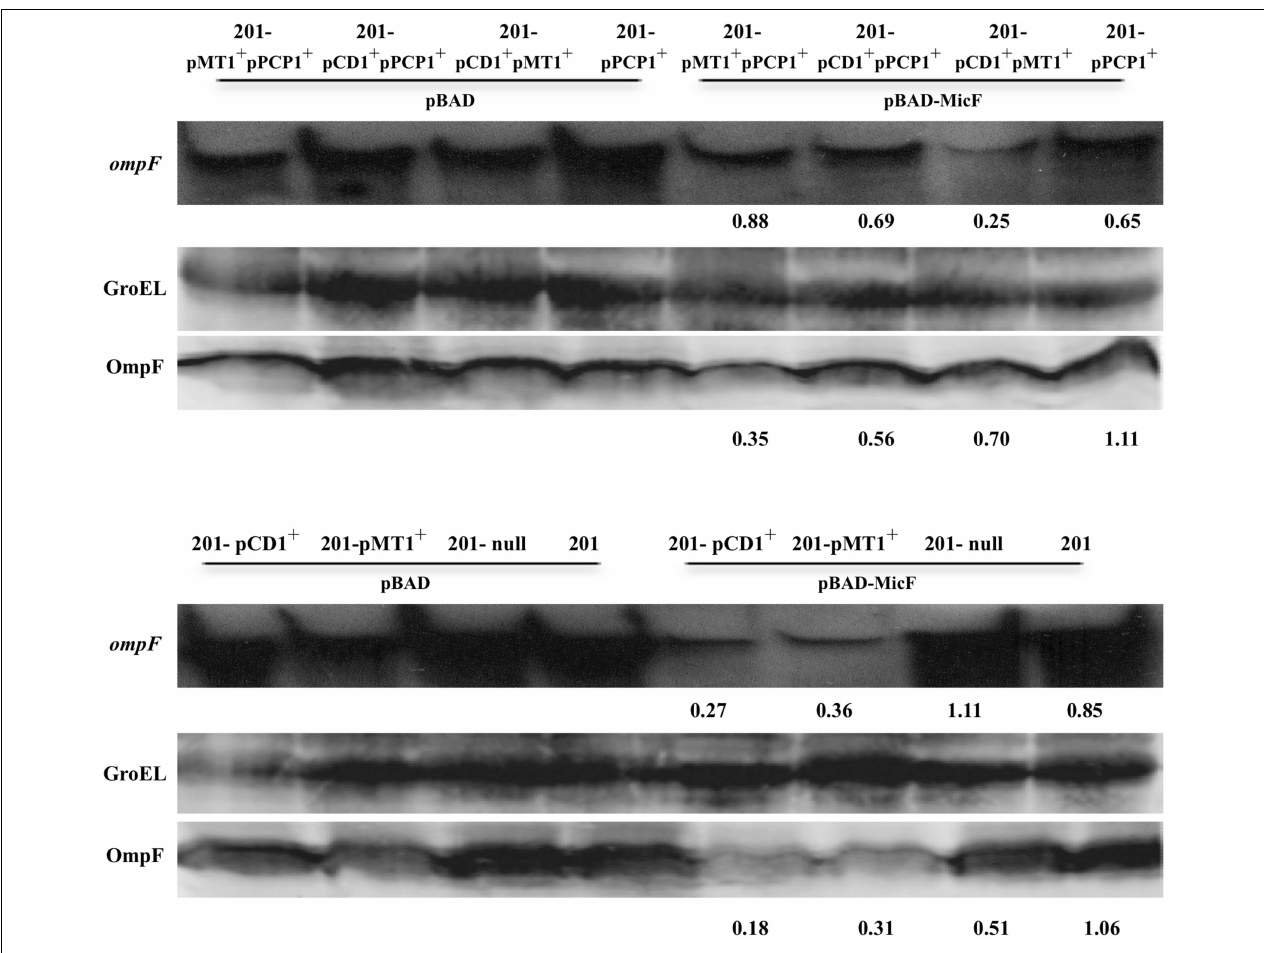
Blot to detect the endogenous OmpF protein in the indicated strains, in which GroEL protein images from each strain were provided as control. The numbers indicated below each panel represent the fold changes of mRNA or protein abundance detected in strains carrying pBAD-MicF divided by that of the corresponding strains carrying pBAD control